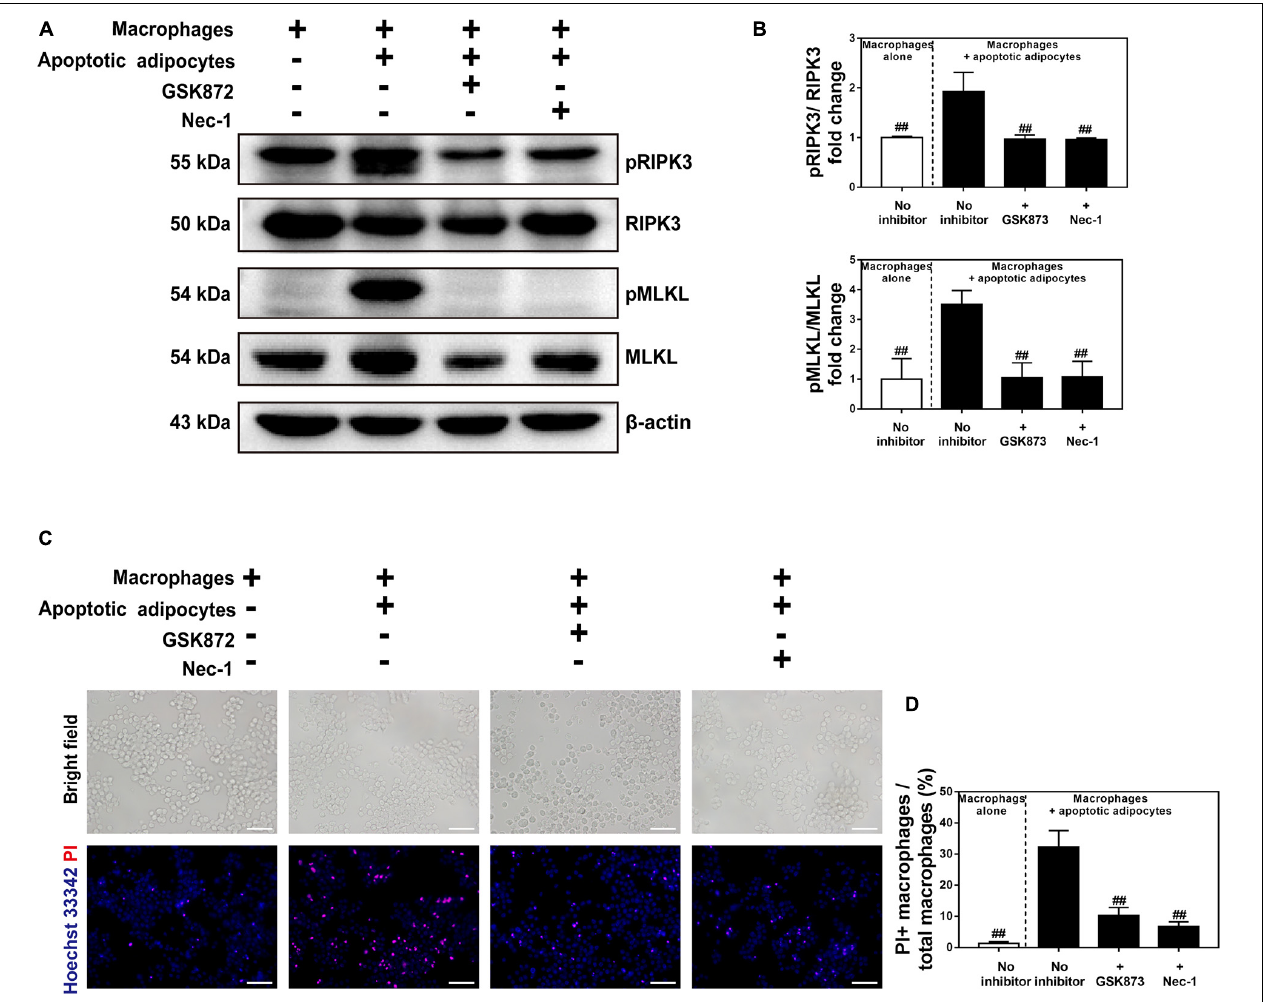
FIGURE 6 | Necroptosis inhibitors suppressed necroptosis of MFCs in the in vitro CLS cell culture model. (A,B) Western blot analyses of MLKL, pMLKL, RIPK3, and pRIPK3 in four groups, including RAW 264.7 macrophages cultured alone, and those in CLS cell culture incubated in the presence or absence of a necroptosis inhibitor (Nec-1 or GSK872) at 96 h. (C,D) Necrosis of macrophages determined by Hoechst 33342 and PI staining in four groups of RAW 264.7 macrophages cultured alone, and those in CLS cell culture incubated in the presence or absence of a necroptosis inhibitor (Nec-1 or GSK872) at 96 h. Scale bars = 50 µ m. Data are presented as the mean ± SD. ## P < 0.01 compared with the CLS cell culture model group incubated without necroptosis